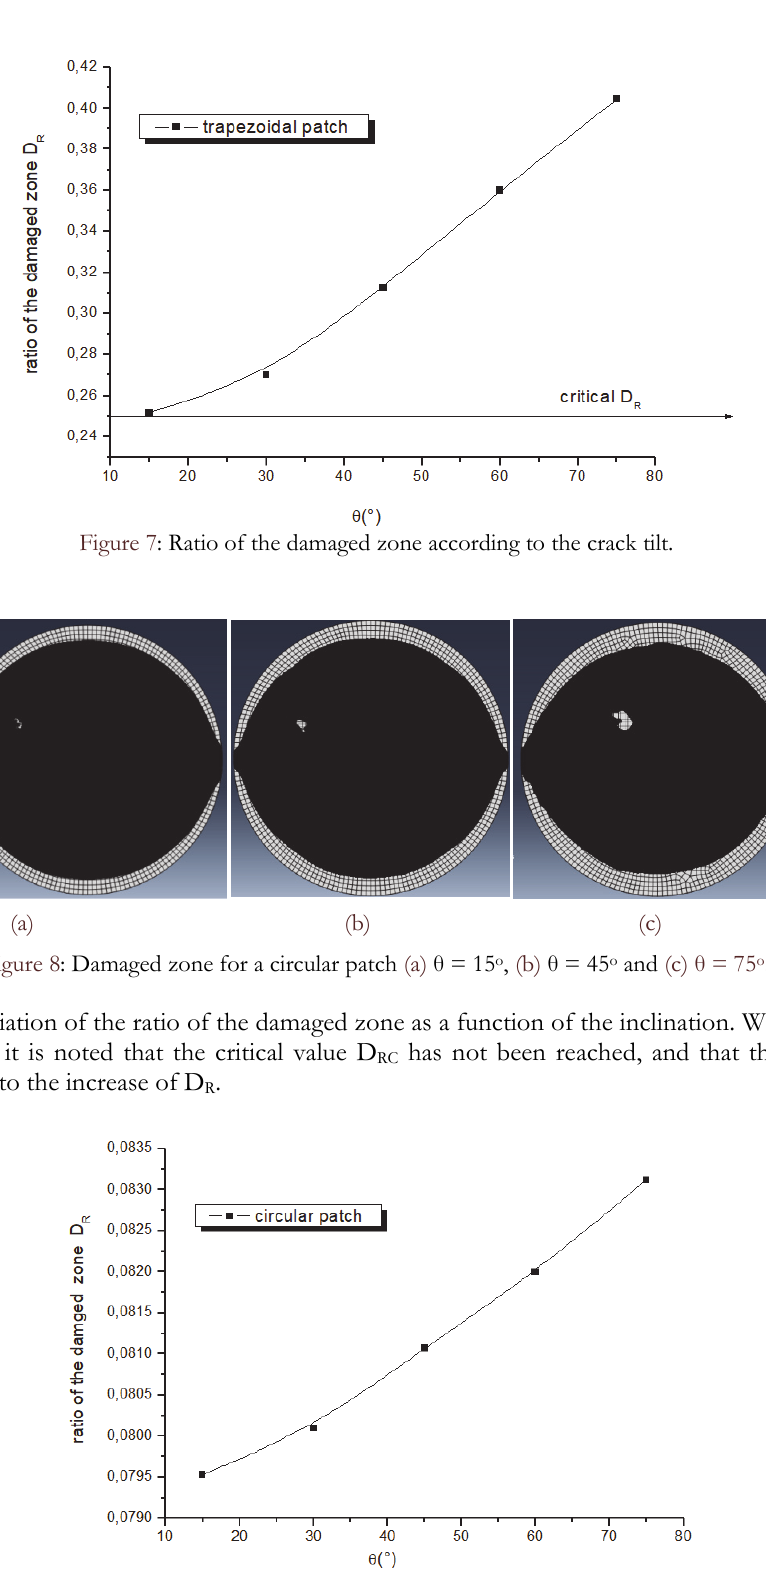
Figure 9: Ratio of the damaged zone according to the crack